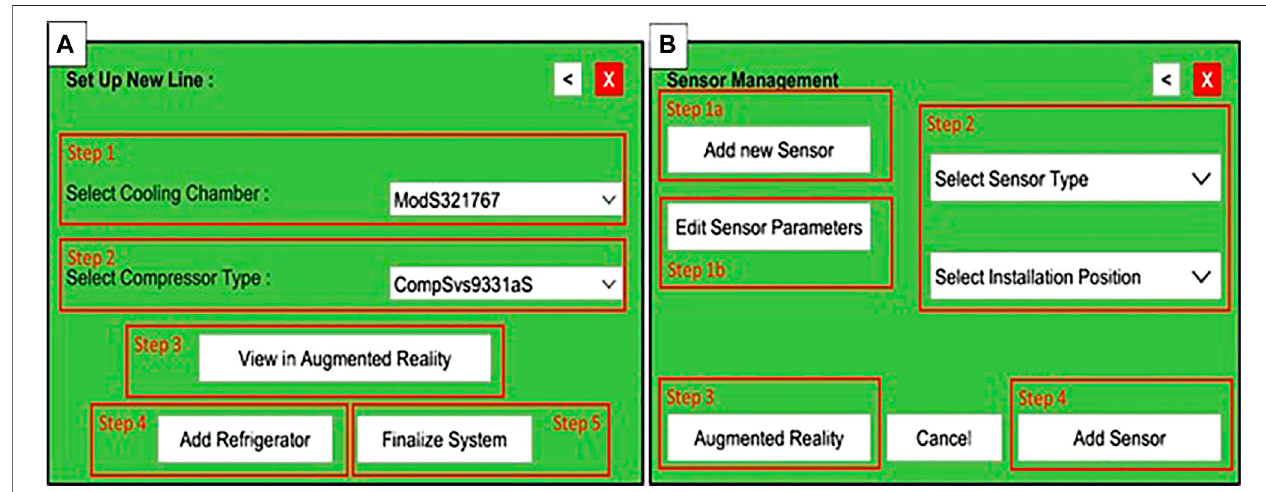
FIGURE 7 | (A) Settings for a new refrigerator line; (B) Settings for new/old sensors.